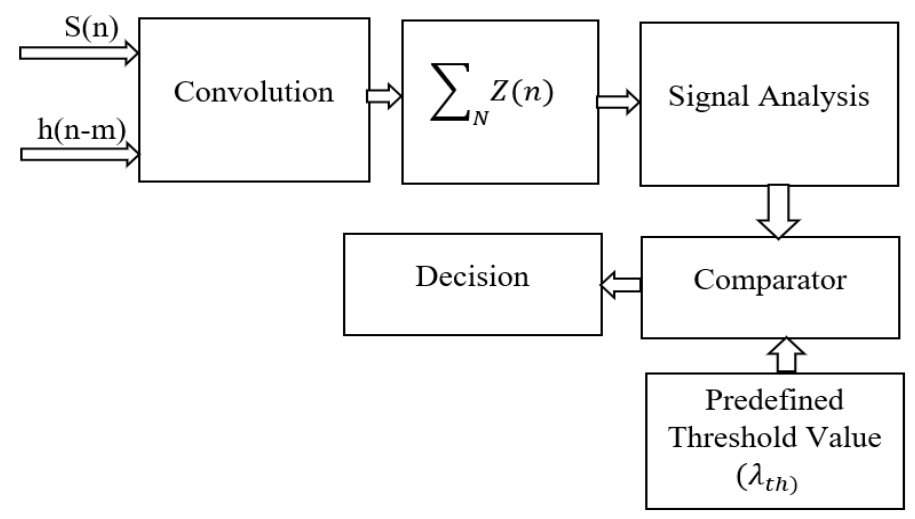
Figure 2. Matched filter convention for spectrum sensing.